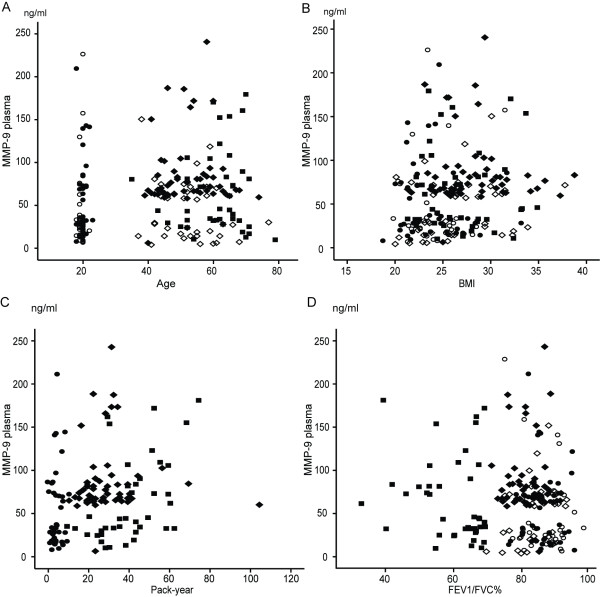
Relationship between plasma MMP-9 levels and the demographic parameters, age (A), BMI (B), pack-years (C) and FEV1/FVC% of predicted (D), in all of the subjects. ○ = young non-smokers; ● = young smokers; ◊ = middle aged/elderly non-smokers; ♦ = middle aged/elderly smokers; ■ = COPD patients.